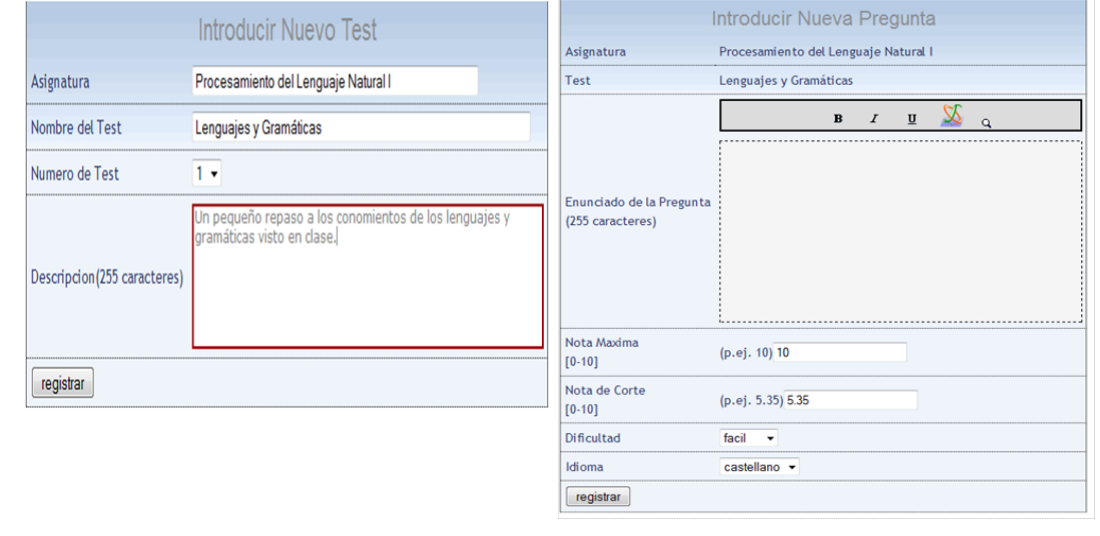
Figure 2 . Creation page of a new test (a) and creation form of a new question